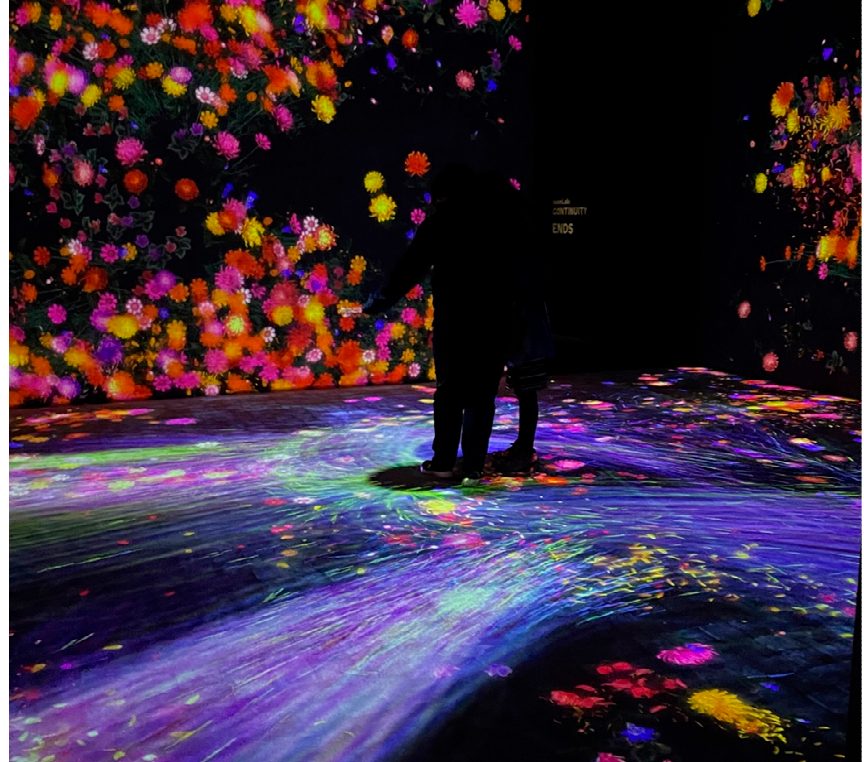
Figure 5. teamLab, Forest of Flowers and People: Lost, Immersed and Reborn, 2017/2021 and The Way of the Sea, Flying Beyond Borders–Colors of Life, 2018/2021, Asian Art Museum of San Francisco; photograph by the author, 2022.